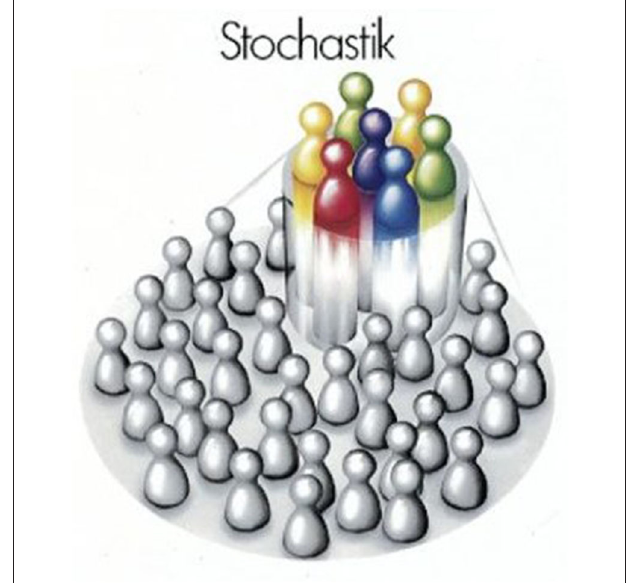
FIGURE 1 | Sampling using frequencies: cover image of a German schoolbook for upper-secondary level mathematics (source: Diepgen et al.,